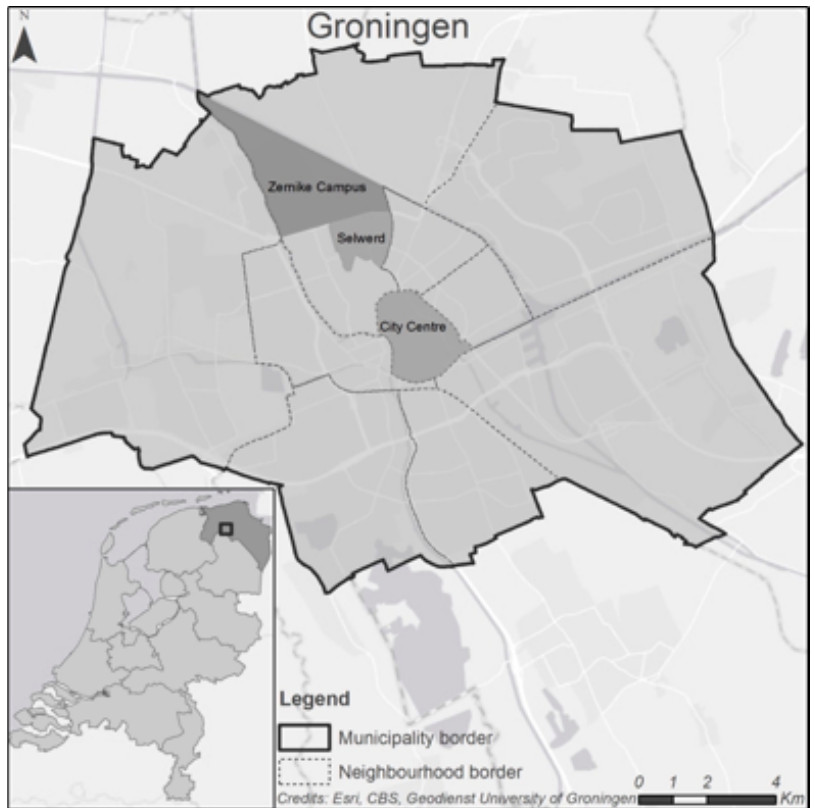
Figure 2. The neighbourhood of Selwerd, located between the Zernike Campus and Groningen city